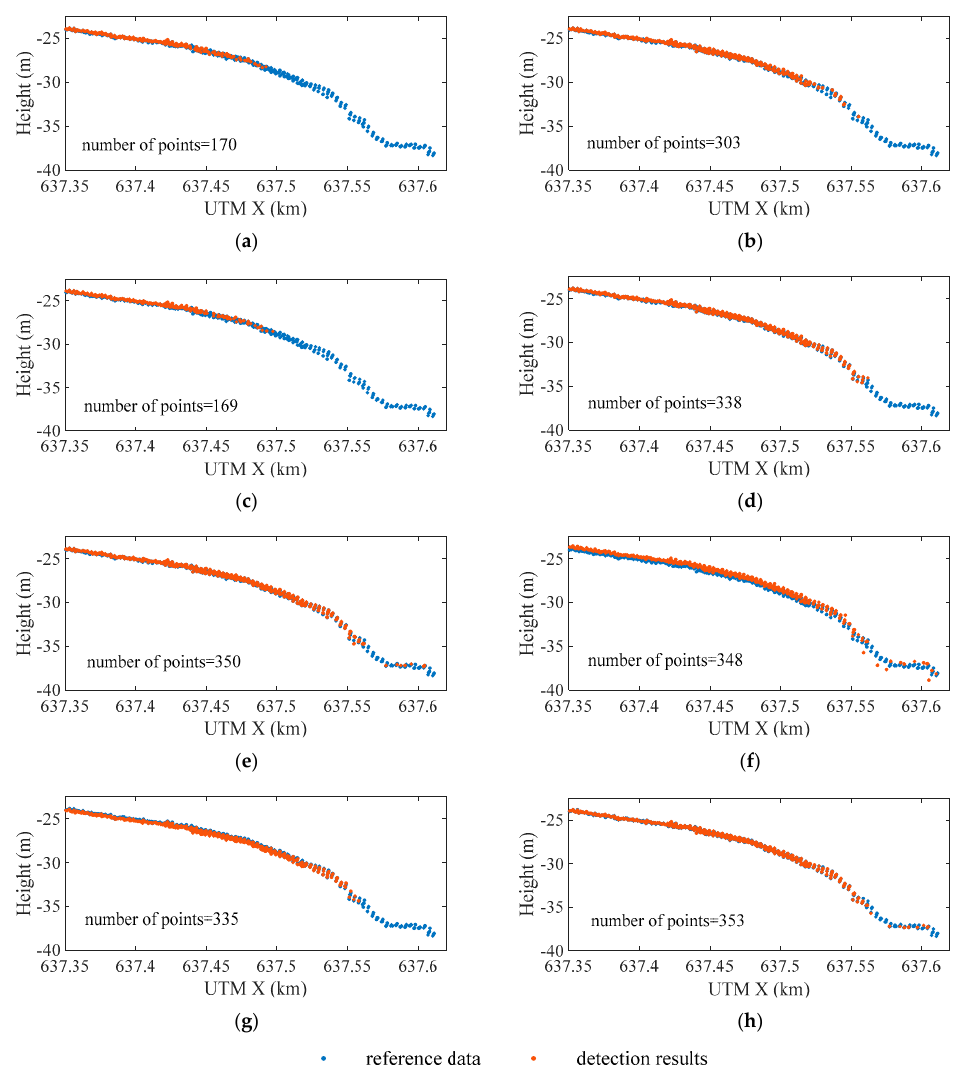
Figure 20. Locations of the water bottom on the selected profile from: ( a ) Max; ( b ) ASDF_M; ( c ) RLD_M;